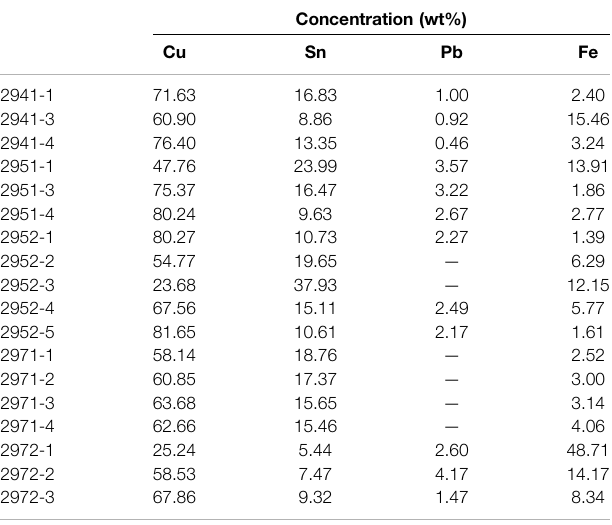
TABLE 4 | Concentrations of the main XRF-identi fi ed elements.